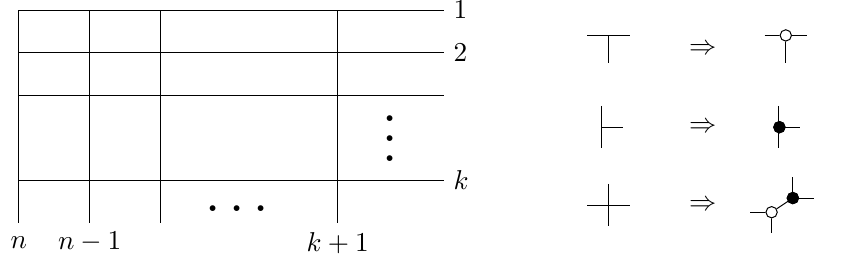
Figure 5 . Top-cell on-shell diagram for A k;n on-shell